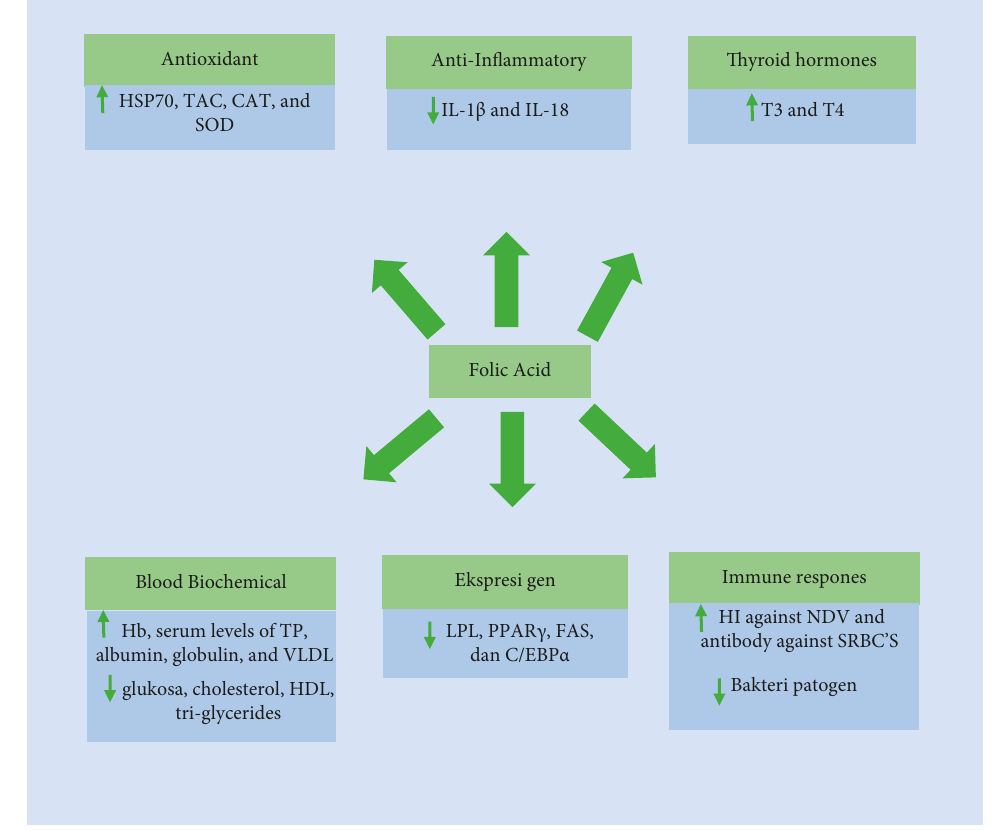
Figure 3: Effect of folic acid on animal Table 3: Effect of folic acid on poultry health.